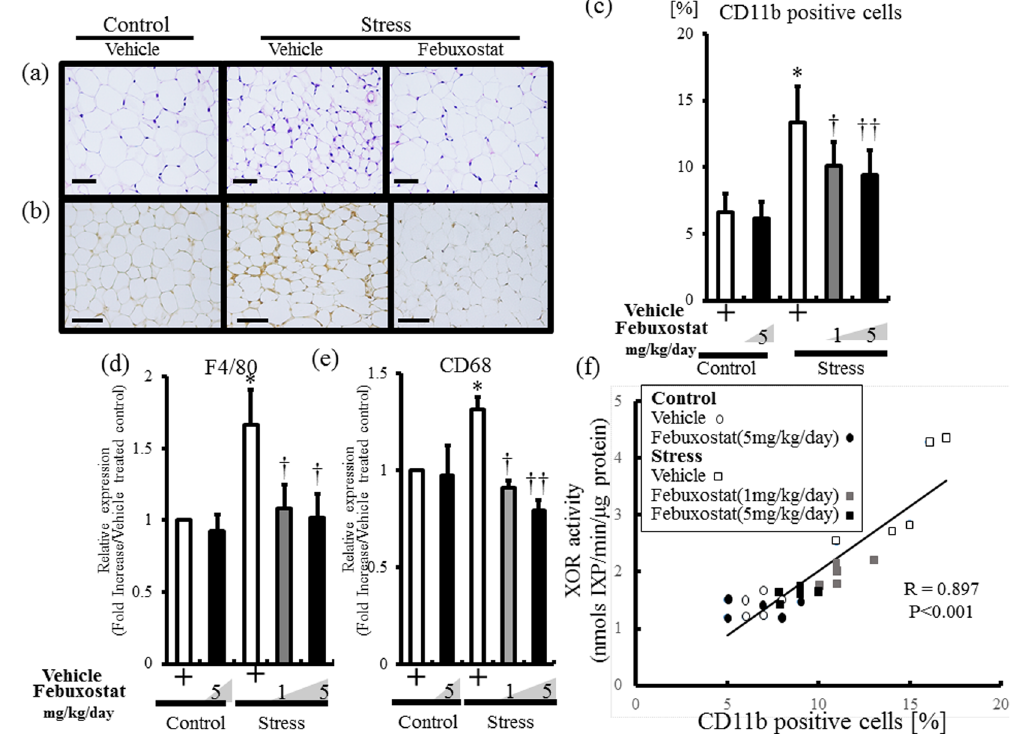
Figure 7. Febuxostat prevents stress-induced adipose tissue inflammation. Inguinal adipose tissues of stressed and control (non-stressed) mice were analyzed by H & E staining ( a ), CD11b immunostaining ( b , c ) and mRNA expression levels of CD68 and F4/80 ( d , e ). ( a ) Accumulation of mononuclear cells in inguinal adipose tissues following 2-week restraint stress. Top panel, × 200 magnification, bar = 50 µ m. ( b ) CD11b-positive cells (monocytes) in adipose tissue of stressed mice ( × 200 magnification, bar = 50 µ m). ( c ) Quantitative analysis of CD11b-positive cells relative to total number of nuclei. Data are mean ± SD of 8 mice per group. * P < 0.001, compared with the vehicle-treated control mice, † P < 0.002 and †† P < 0.001, compared with